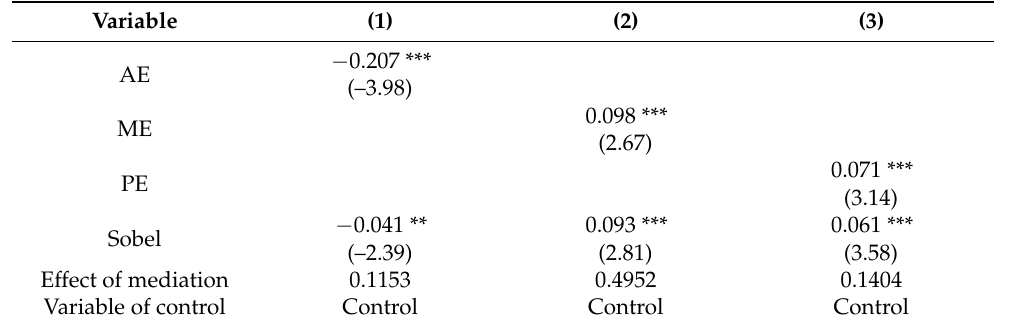
Table 5. Test of mediating